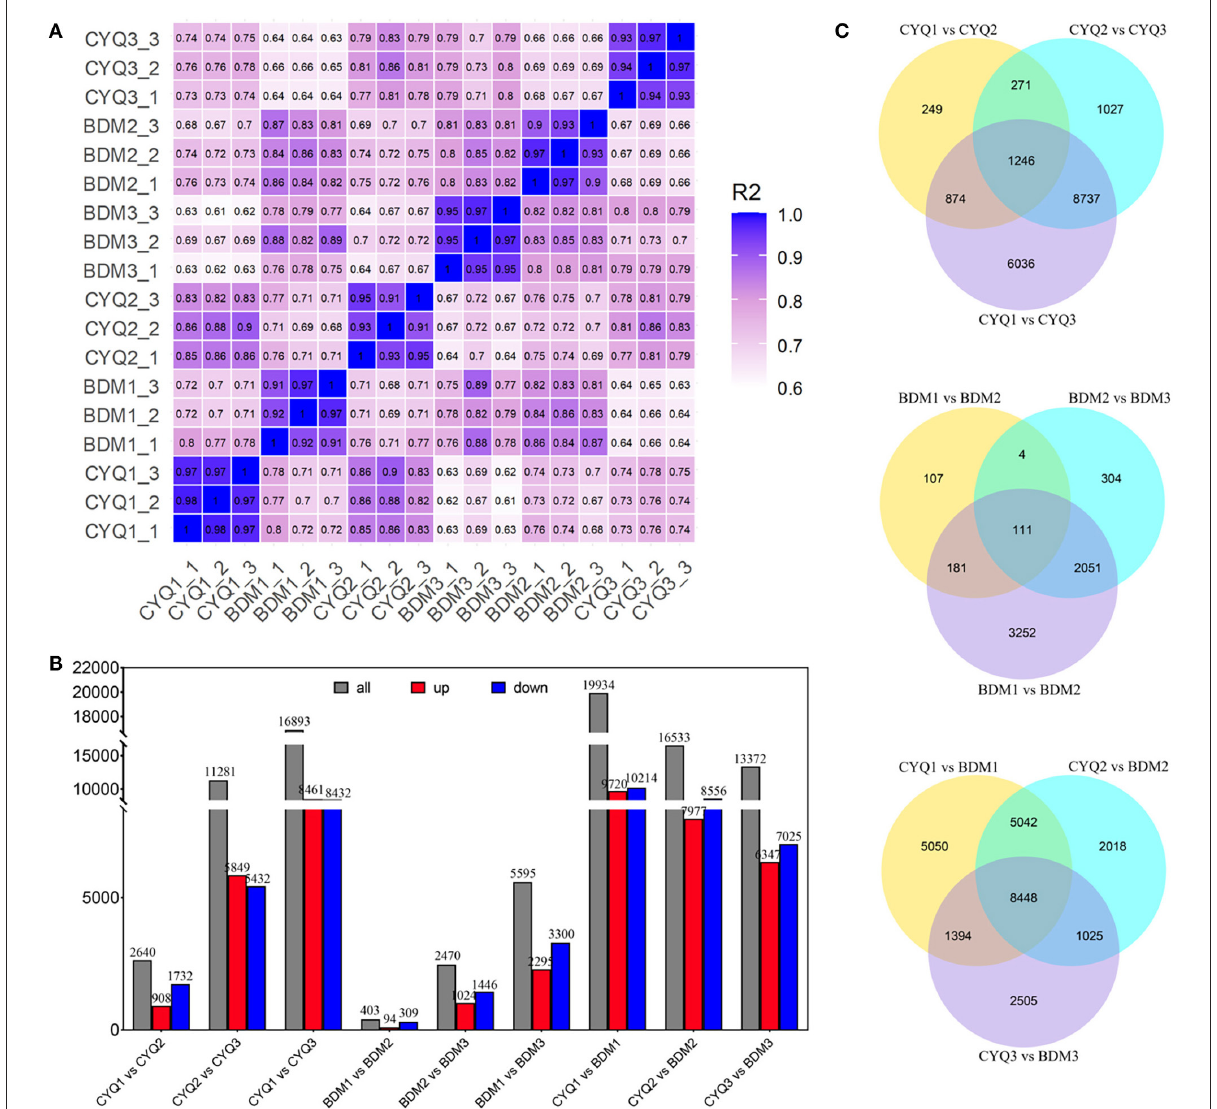
FIGURE2 RNA-seq data expression patterns of CYQ and BDM samples. (A) Heatmap of squared multiple correlation coefficient of the expression of all transcripts between every two samples. (B) The number of up- and down-regulated DEGs in the different compared combinations. (C) Venn diagram of co-expressed and uniquely expressed DEGs for the pairwise comparisons.